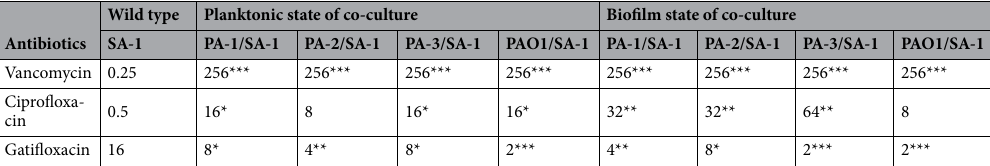
Table 2. Antibiotic susceptibility of recovered S. aureus strains. * P-value < 0.01; **P-value < 0.001; ***P-value < 0.0001.